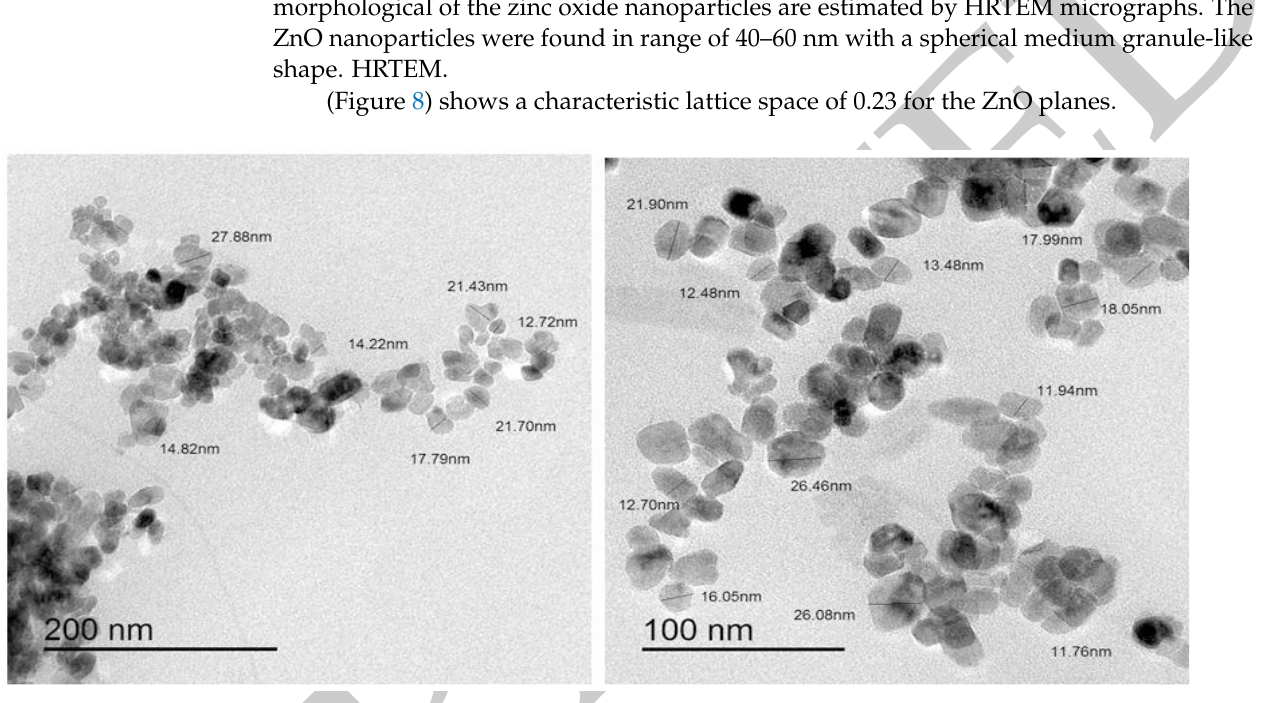
Figure 7. TEM with 100 and 200 nm scale of ZnO-NPs estimated the size and morphology of the zinc oxide nanoparticles that were found in a range of 40–60 nm, with spherical medium granule-like-shape.